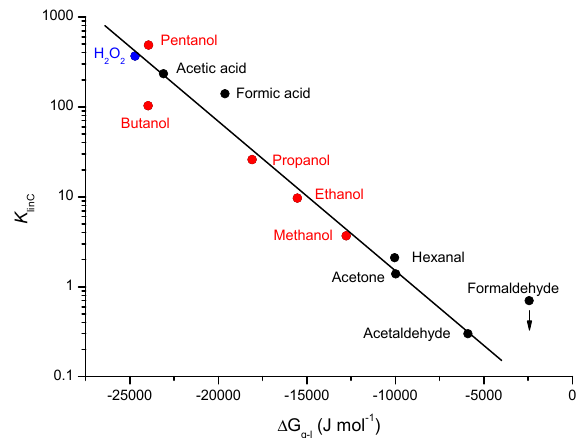
Fig. 13. Plot of K LinC at 228 K versus the free energy of conden- sation ( 1DG g − l ) for a range of organic alcohols (red), organic car- bonyl compounds (black), and an inorganic compound (blue). The data point for formaldehyde has little confidence as argued by Pou- vesle et al. (2010). Figure published with kind permission from John